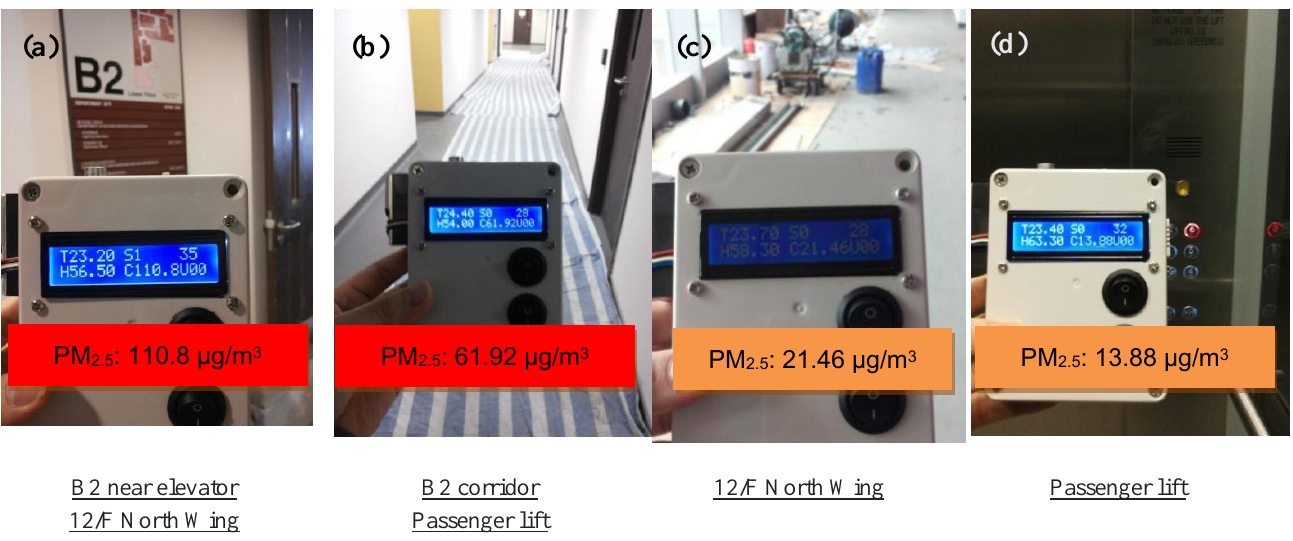
Figure 15. PM 2.5 concentration in ( a ) basement; ( b ) basement corridor; ( c ) the 12/F; ( d ) the passenger lift.